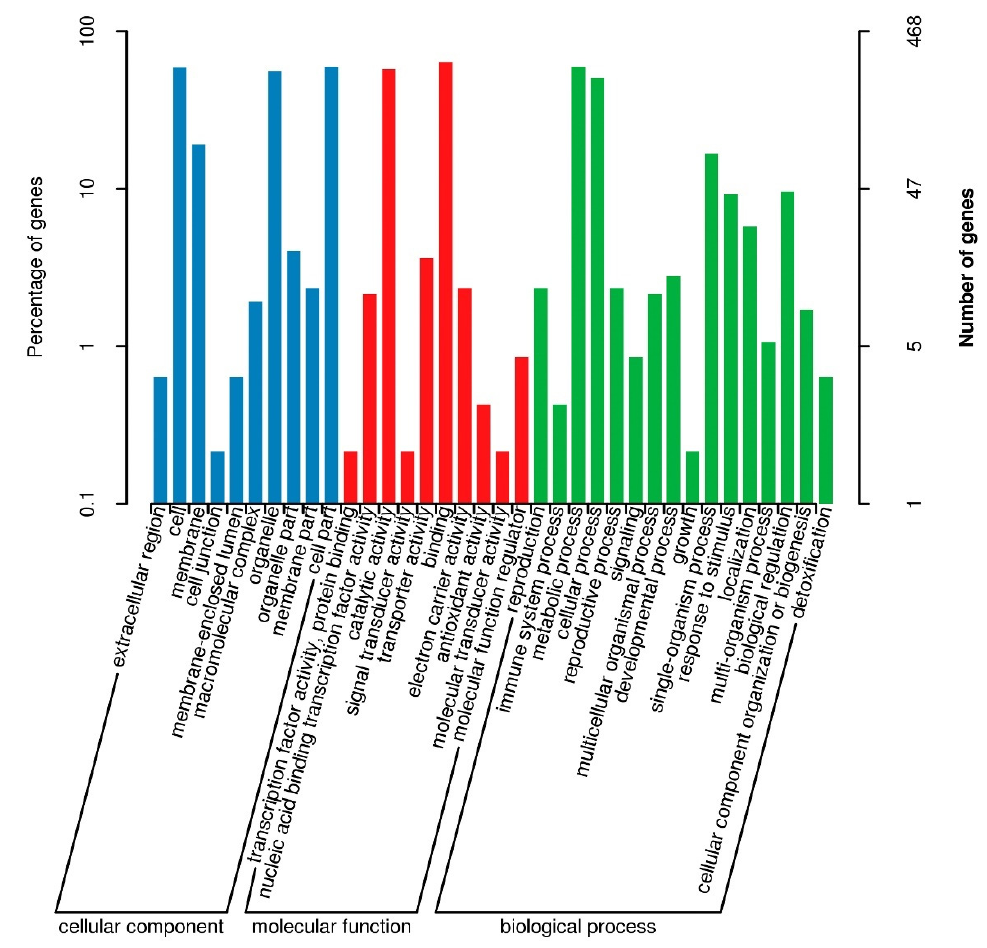
Figure 5. The Gene Ontology (GO) enrichment analysis of candidate regions.